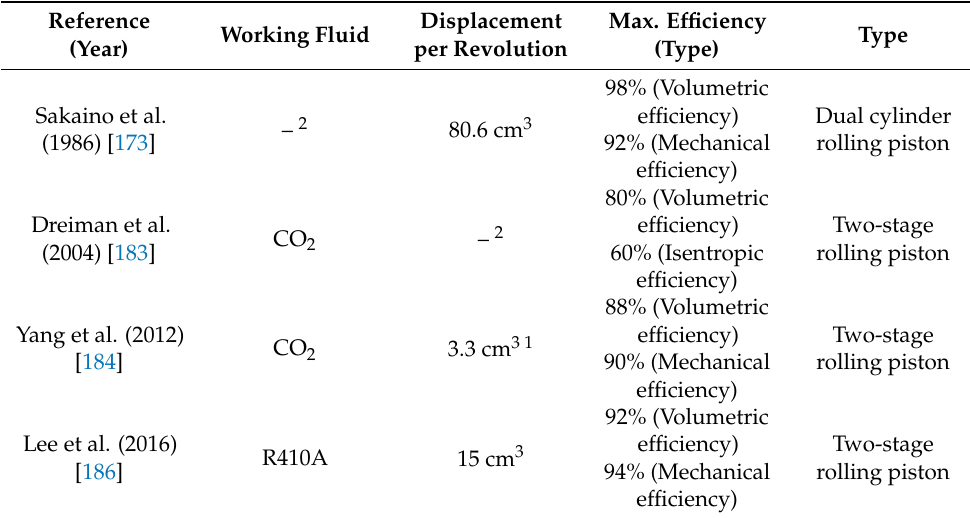
Table 6. Performance of dual cylinder and two-stage rolling piston